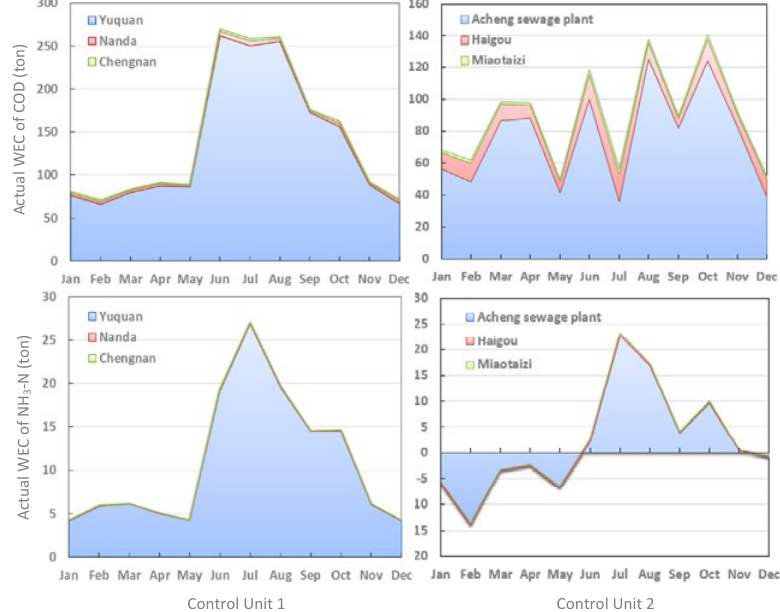
Fig. 8: Actual dynamic water environmental capacity of COD and NH 3 -N at each outlets and control units